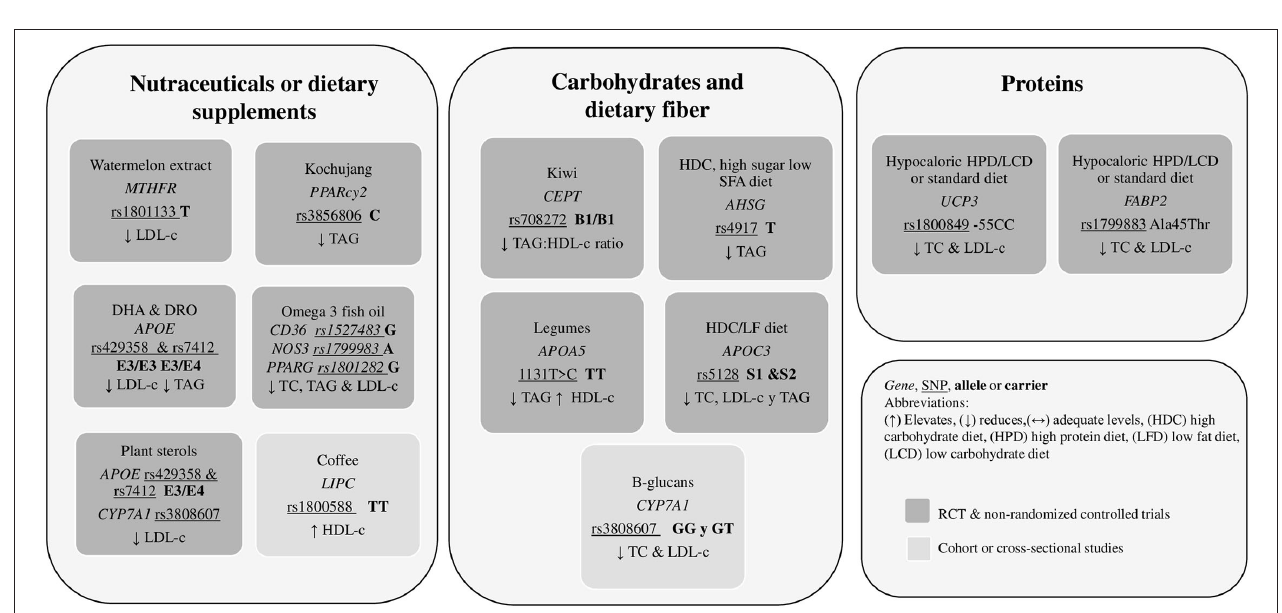
FIGURE 2 | Dietary recommendations related to gene variants and dietary fat intake.